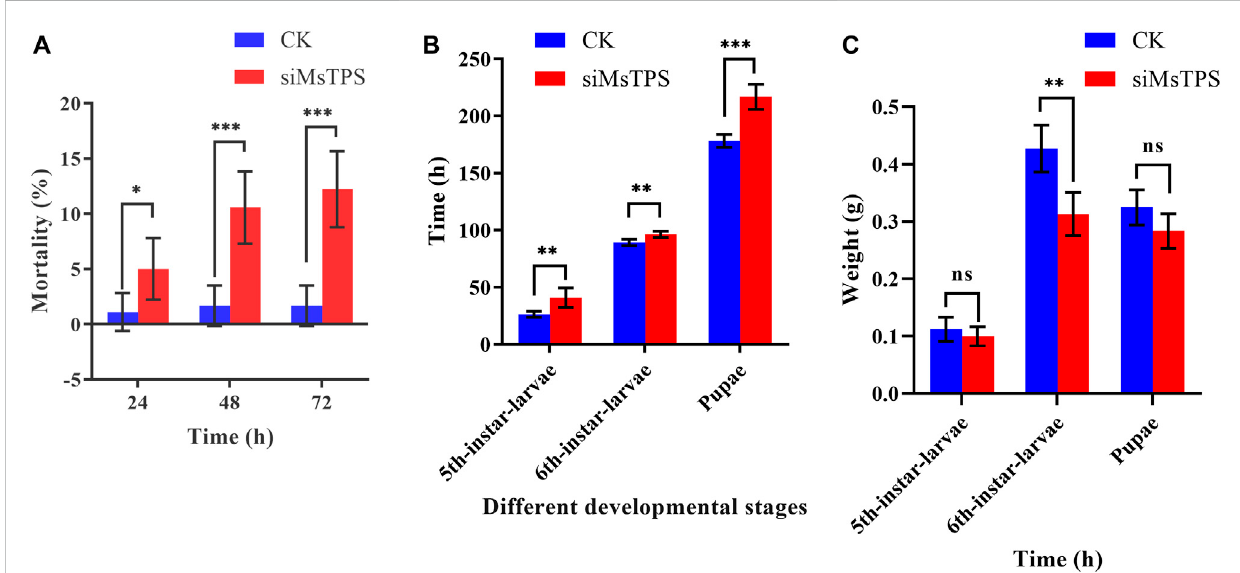
Effect of the silencing of MsTPS on M. separata mortality (A) , developmental time (B) , and weight (C) . Data are presented as the mean ± SE. Statistically signi fi cant differences by t -test at same treatment time shown as asterisks (* p < 0.05, ** p < 0.01, *** p < 0.001, ns >